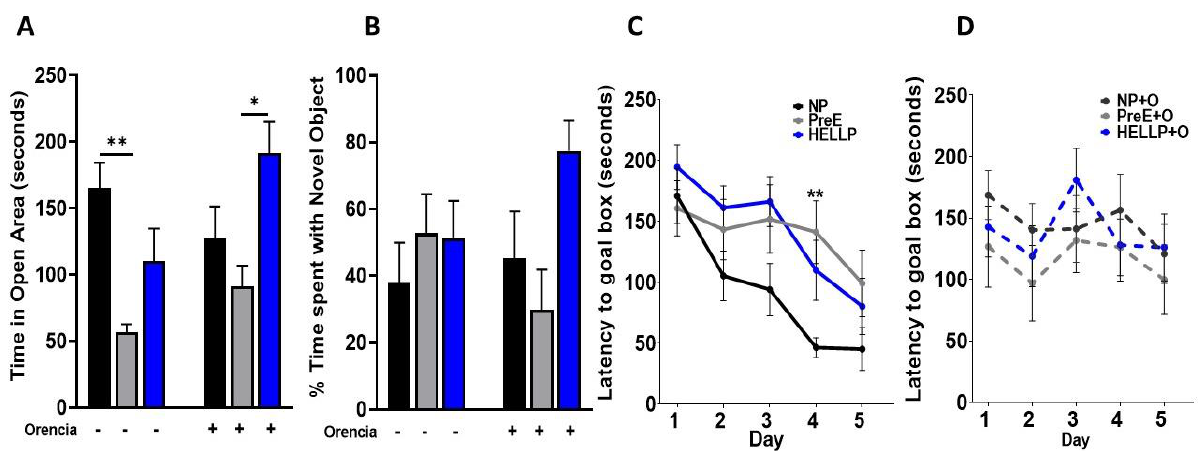
Figure 4. Dams with a hypertensive disorder of pregnancy (HDP) have anxiety and delays in learning. PreE rats spent significantly more time in the open arms of the elevated plus maze, a behavior which was not corrected by Orencia infusion ( A ). There were no significant differences between groups observed in the discrimination index for novel object recognition ( B ). When Barnes maze was assessed over 5 days, only on day 4 were significant differences observed ( C ). However, there was an overall increase in latency to reach the goal box among HDP rats. There was no statistical change in memory due to Orencia administration ( D ). Data were analyzed by two-way ANOVA followed by Tukey’s post hoc test and presented as mean ± SEM (n = 11–13/group). *–** denotes p < 0.05– p < 0.005 in comparison to the indicated group. Abbreviations: NP (normal pregnant); PreE (preeclampsia); HELLP (hemolysis elevated liver enzyme low platelet).